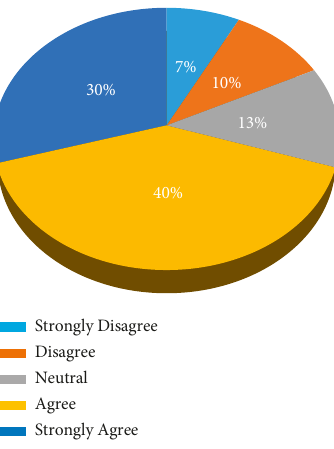
Figure 2: Low implementation cost.